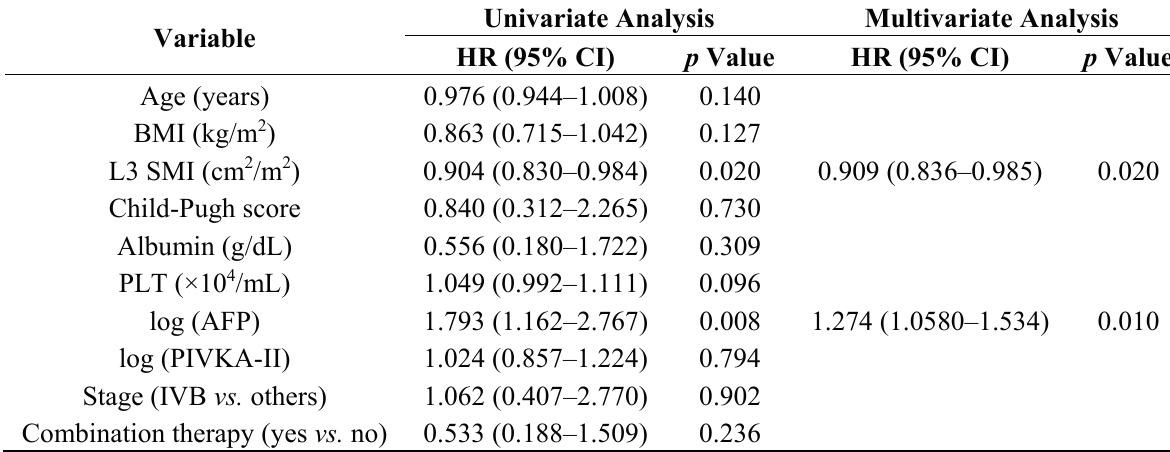
Table 2. Univariate and multivariate analyses of possible risk factors for overall survival of hepatocellular carcinoma patients by the Cox proportional hazards model.